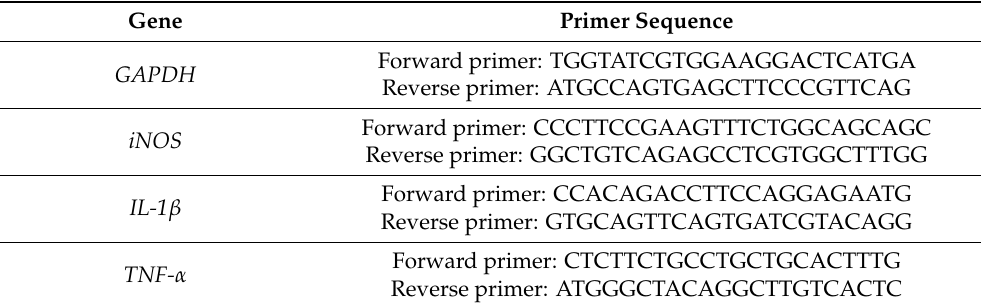
Table 1. Primer sequences used for pro-inflammatory gene expression.